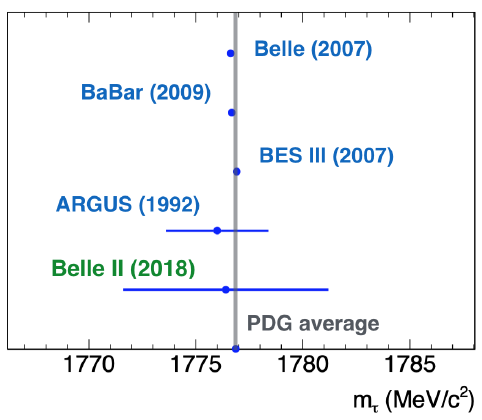
Figure 5: Comparison between the τ lepton mass measurement performed by Belle II and the values obtained from previous experiments. τ lepton mass average reported by the PDG [ 5 ] is also displayed.